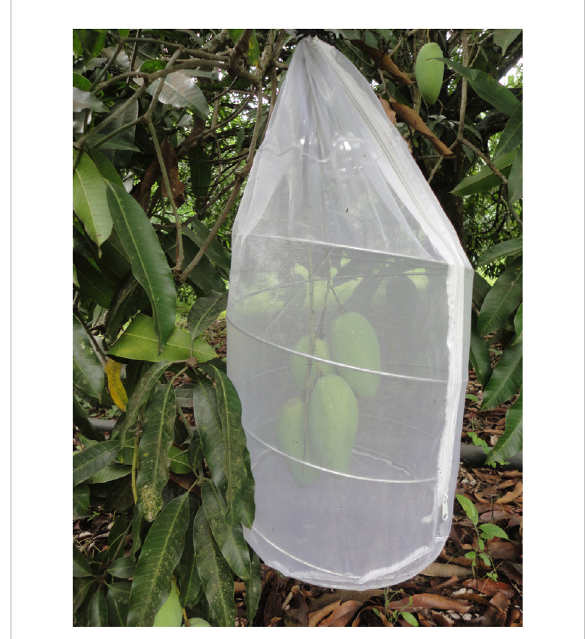
FIGURE 1 White organza fabric cage with mango fruit cv ‘ Manila ’ exposed to gravid females (three females per fruit) during 24 h in the fi eld experiment to generate fruit